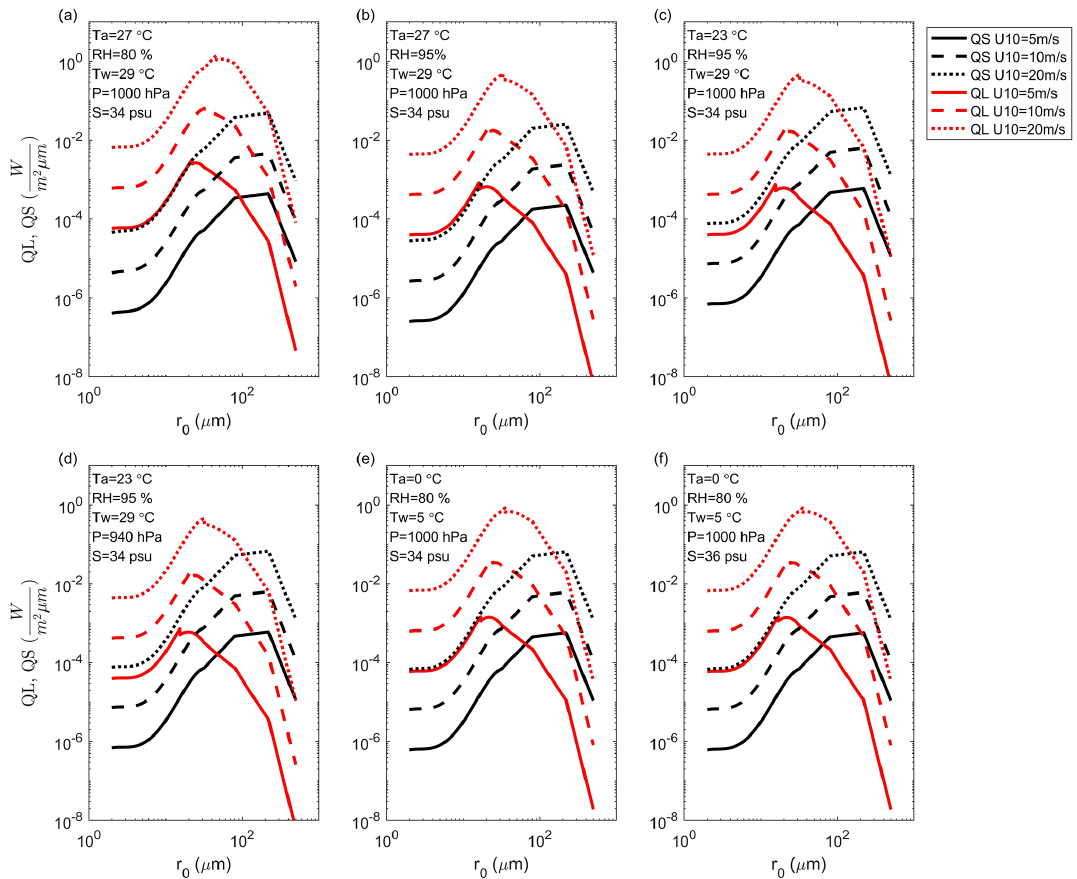
Figure 1. The radius-specific sea-spray-mediated sensible ( Q S : black) and latent ( Q L : red) heat fluxes as functions of initial radius r 0 : U 10 , Ta, RH, Tw, P and S are 10m wind speed, 2m air temperature, 2m relative humidity, sea surface temperature, surface air pressure and surface salinity,